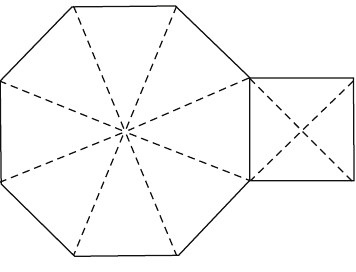
Figure 10: 4.8.8